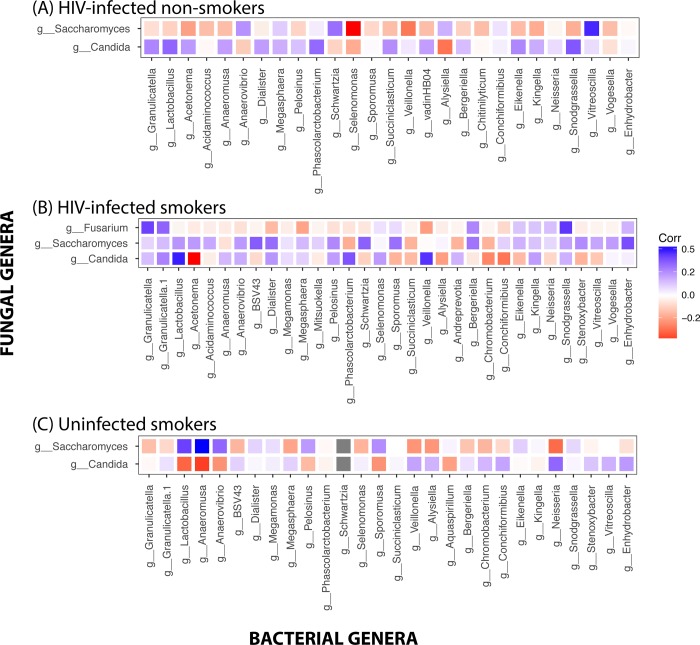
Inter-kingdom correlations between the bacteriome and mycobiome for (A) HIV-infected non-smokers, (B) HIV-infected smokers, and (C) uninfected smokers. Spearman’s correlation for each comparison was determined for the three groups. Blue tiles indicate positive correlation; red tiles indicate negative correlations; tile sizes represent the absolute value of correlation for each pair of the microbe-microbe matrix.